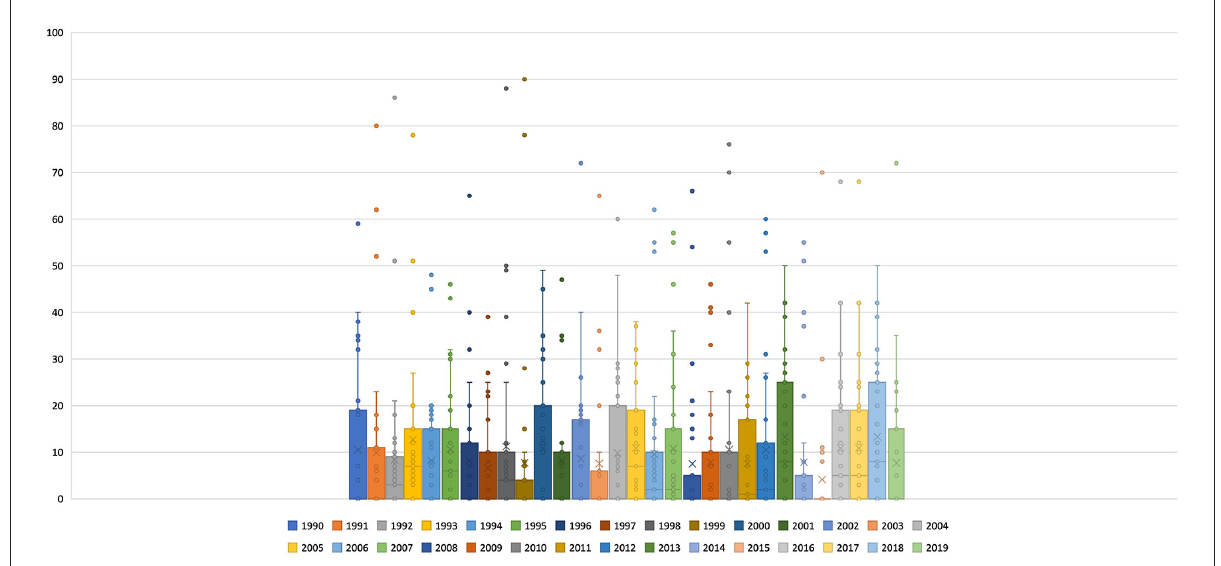
FIGURE7 Range distribution of daily precipitation in May during the last 20 years. The bars express the median and points outside the bars show outliers for the month.